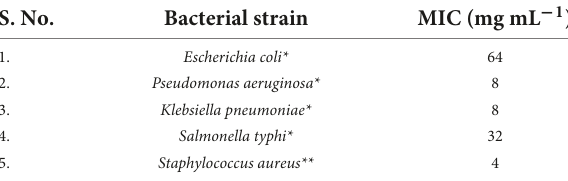
TABLE 6 Minimum inhibitory concentration (MIC) of the most effective plant extract against test